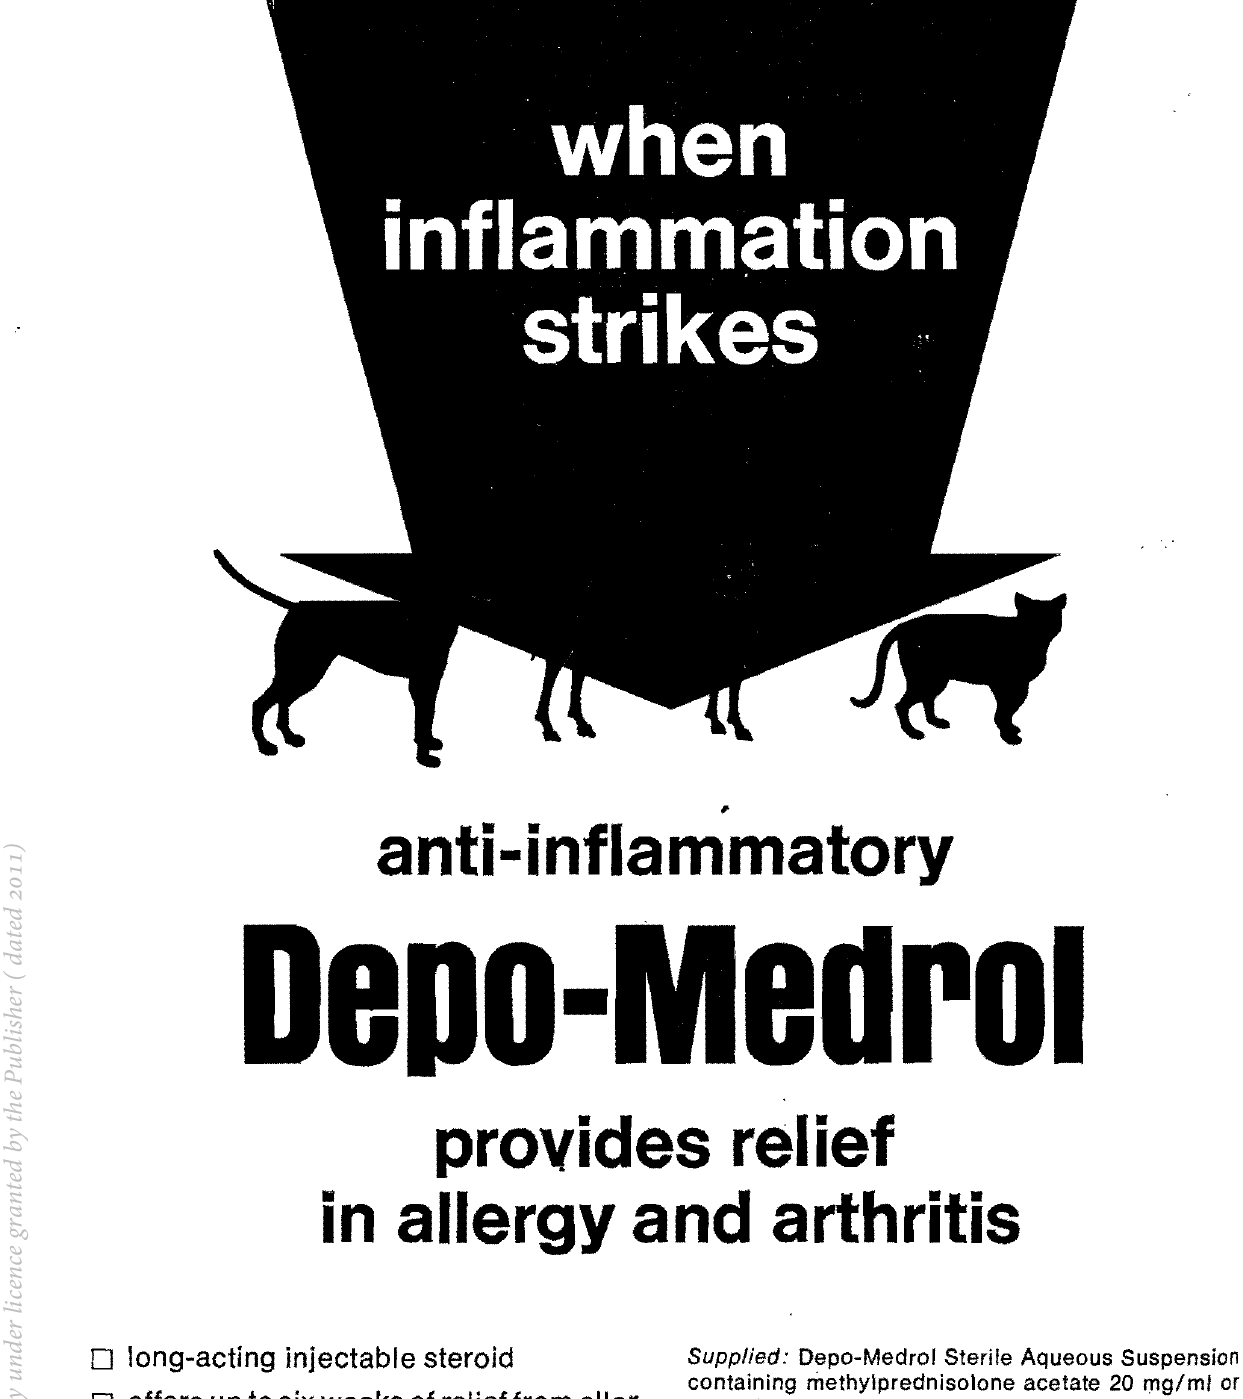
Supplied: Oepo-Medrol Sterile Aqueous Suspension containing methylprednisolone acetate 20 I)1g/ml or 40 mg/ml in 5 ml multi-dose